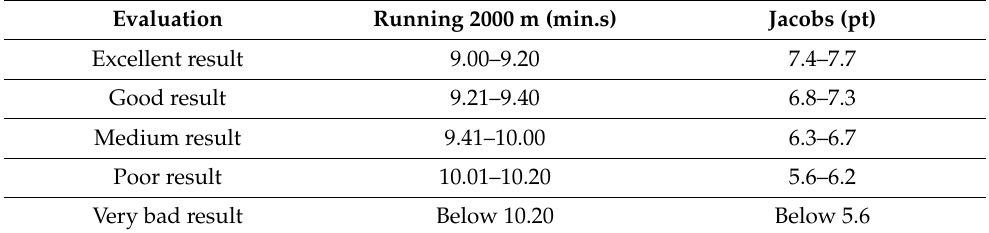
Table 4. Data intervals of Running 2000 [19] and Jacobs [22] for adolescents aged 15–16 years.